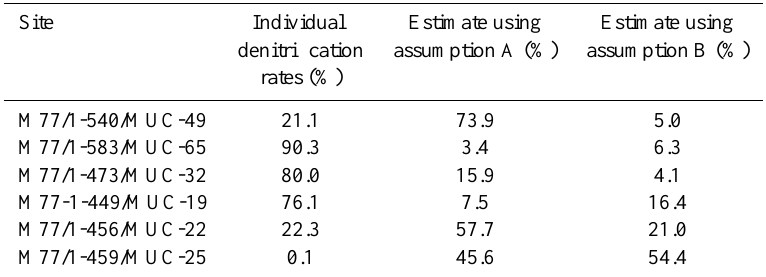
Table 3. Contribution of species with known denitrification rates and assumptions A and B in the calculations of benthic foraminiferal denitrification rates at the different sampling sites. The percentage of living individuals of the three subgroups of species (without assumption, assumption A, and assumption B) to the total foraminiferal abundance is shown. The column “individual denitrification rates” indicates species where literature data for the individual rates was available.